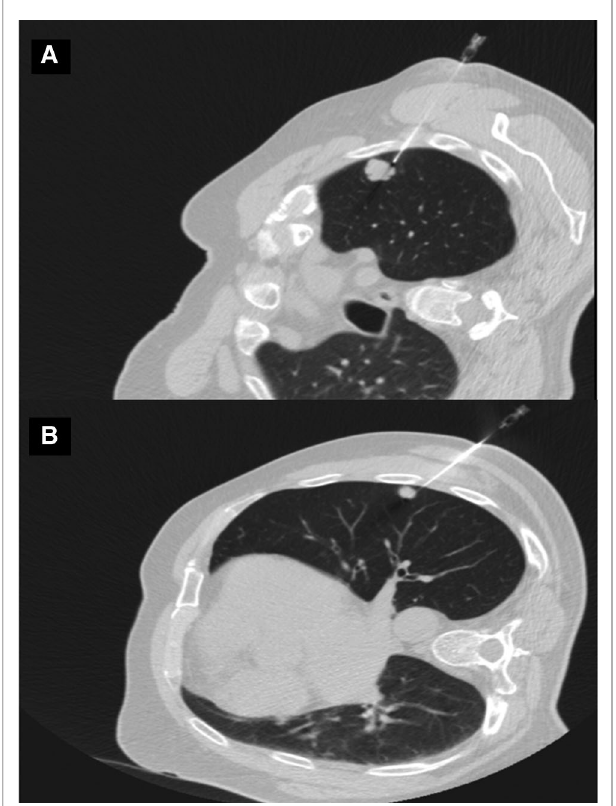
FIGURE 1 | CT scan of two left lung nodules: ( A ) 15 mm upper lobe; and ( B ) 12 mm lower